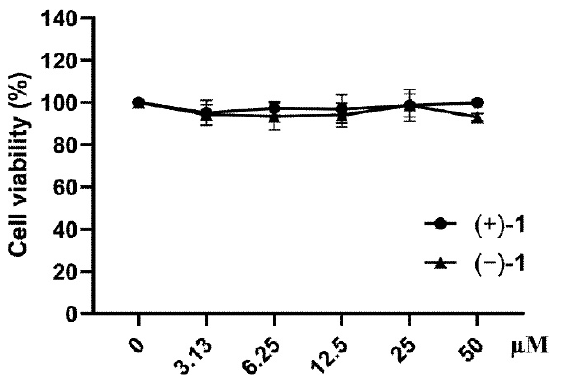
Figure 4. Compounds (+) ‐ 1 and ( − ) ‐ 1 had no effect on RAW 264.7 cells. Values are presented as mean ± SEM of three independent experiments.